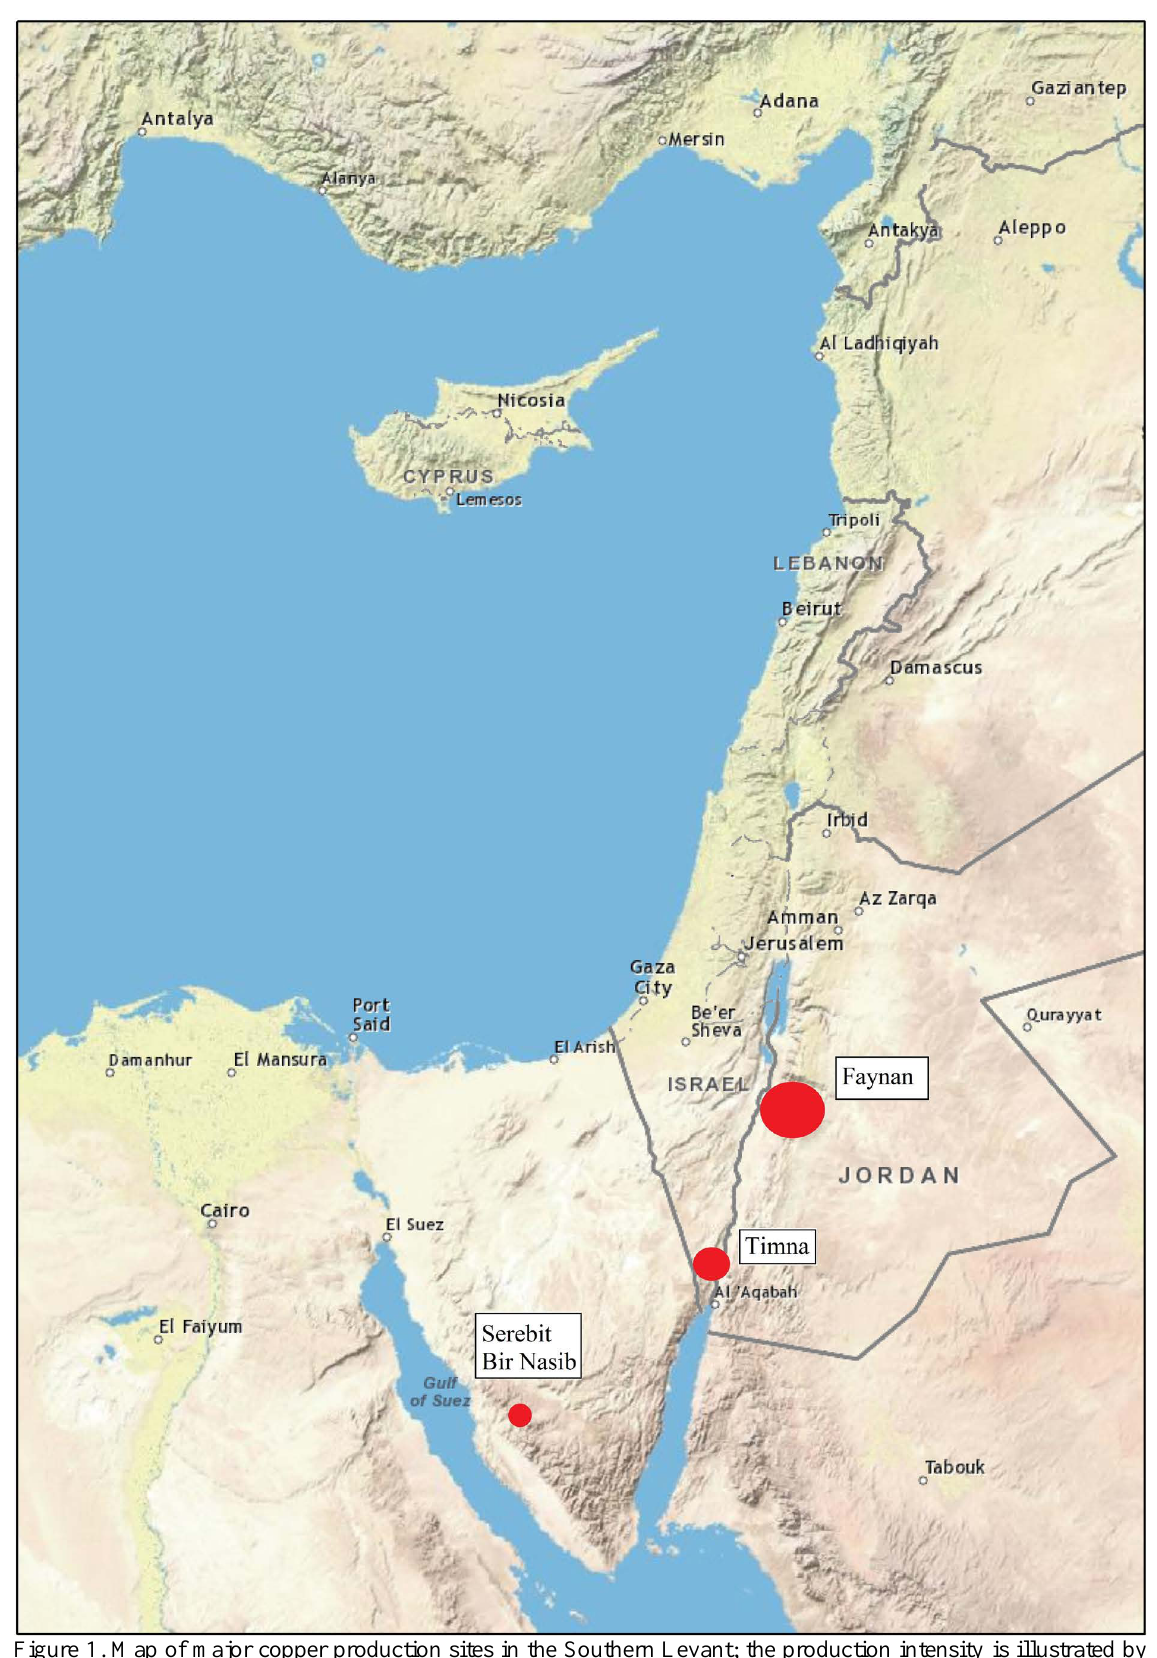
Figure 1. Map of major copper production sites in the Southern Levant; the production intensity is illustrated by the size of the red dots (this map was created using ArcGIS software by ESRI). Sources: US National Park Service, ESRI, DeLorme, MaymyIndia, OpenStreetMap contributors, and the GIS user